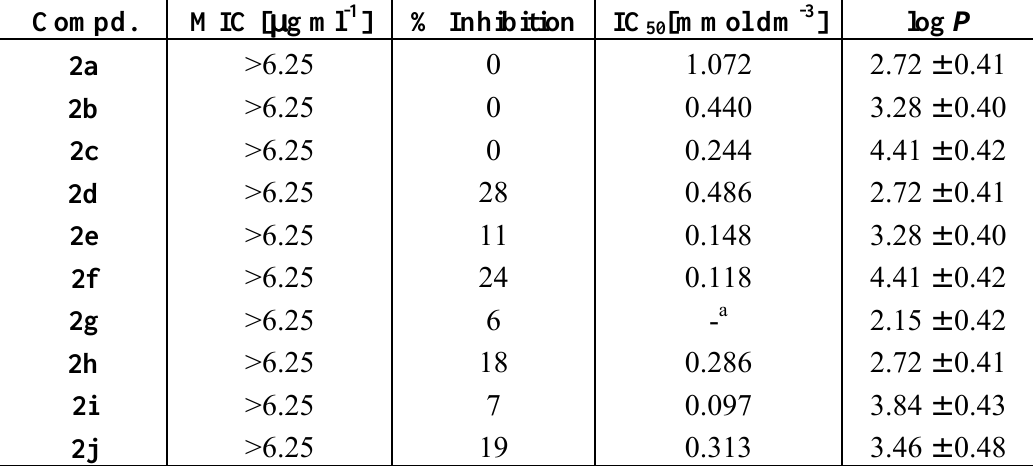
values for inhibition of 50